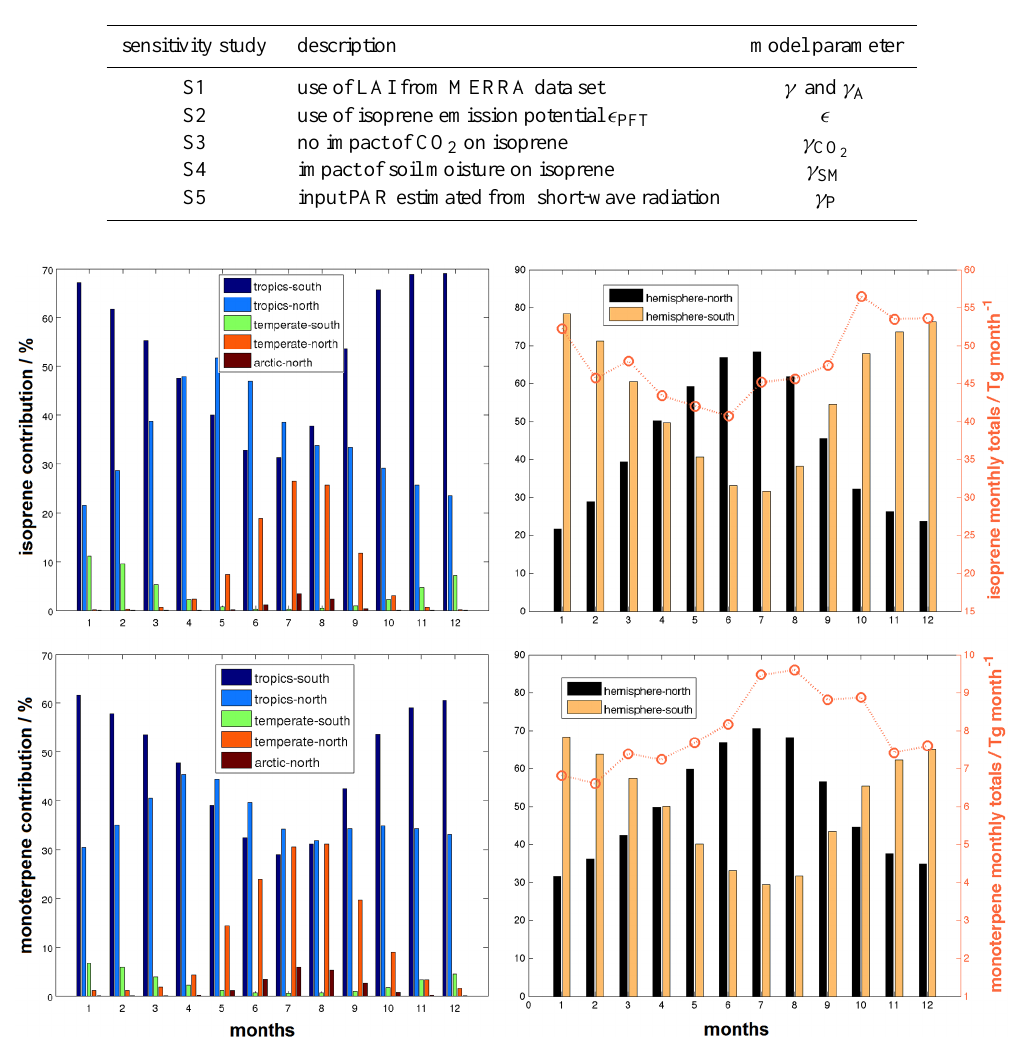
Table 2. List of sensitivity runs performed.